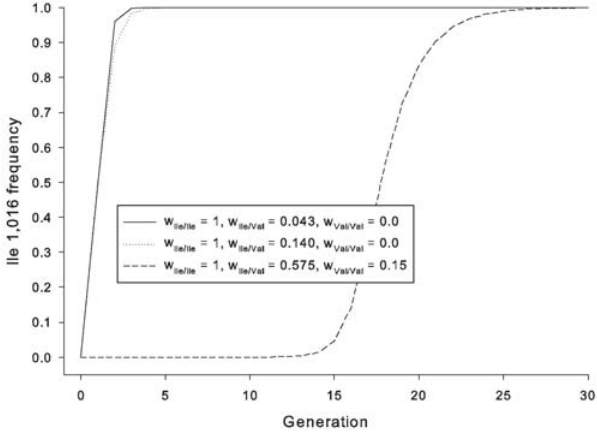
Figure 5. Expected trajectories for the Ile1,016 allele for a single population with an initial Ile1,016 frequency of 0.04% using Fisher’s model of natural selection. Three scenarios are presented. The first two trajectories indicate a rapid fixation of Ile1,016 when Val1,016 is partially dominant (4–14% survival in heterozygous mosquitoes). The third scenario assumes that mosquitoes recover following knockdown. Based upon observation in the laboratory, all Ile1,016 homozygotes recover but 58% of heterozygotes and 15% of Val 1,016 homozygotes recover.